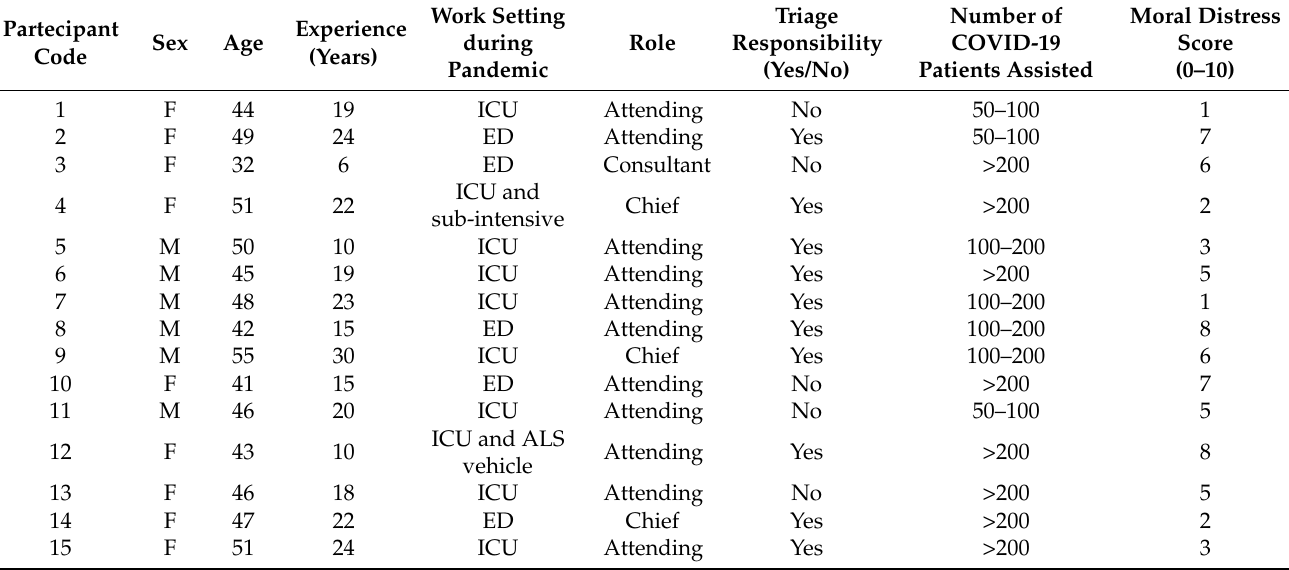
Table 2. Participants’ sociodemographic characteristics and moral distress levels.